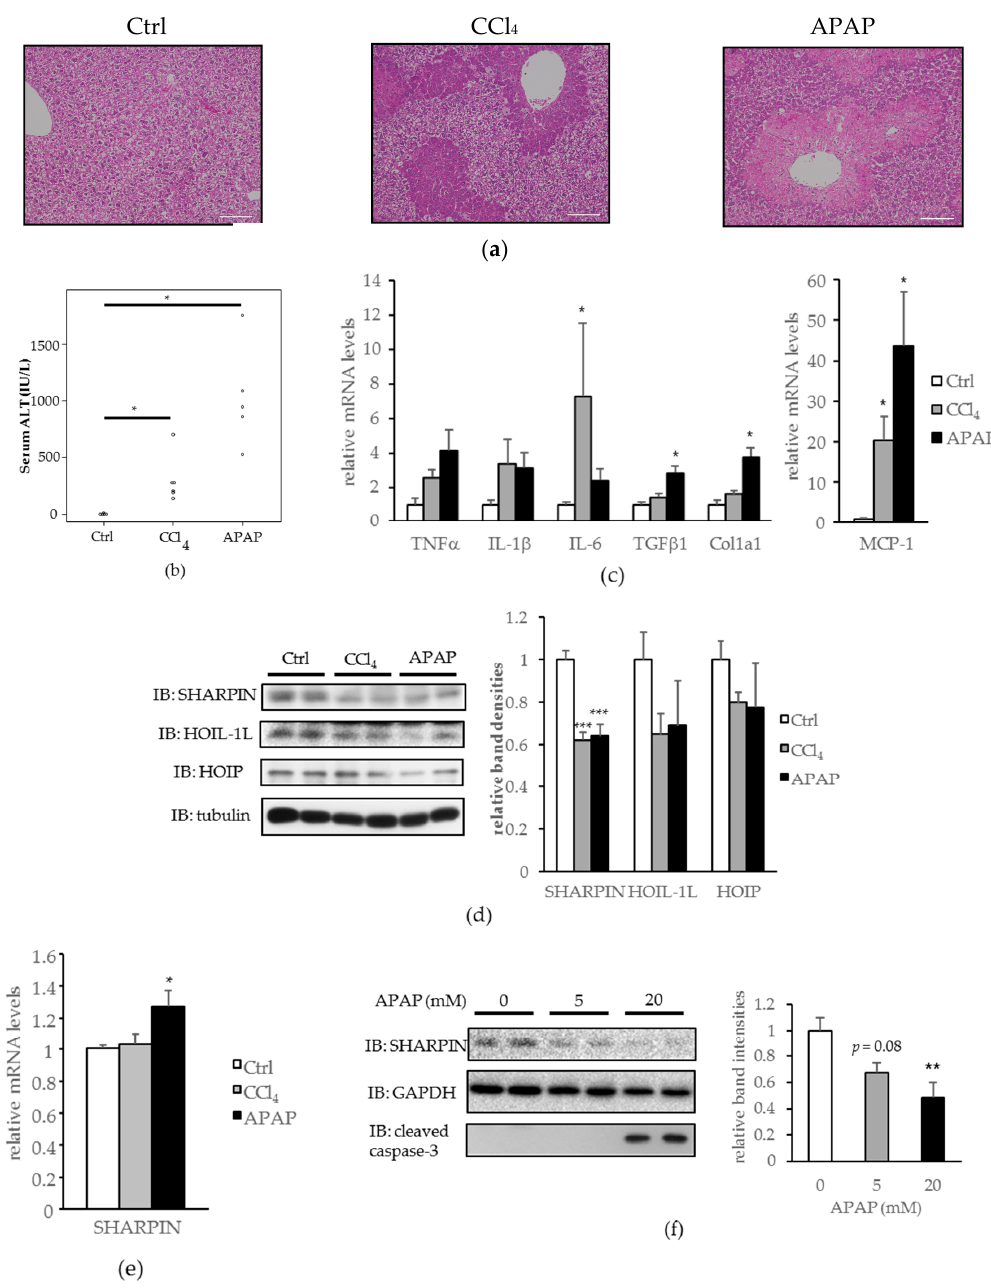
Figure 1. Downregulation of hepatic SHARPIN (SHANK-associated RH domain-interacting protein) by carbon tetrachloride (CCl 4 ) and acetaminophen (APAP) induced acute liver injury in mice, as well as in Hepa1-6 cells treated with APAP. ( a ) Mice were injected with CCl 4 (0.4 mL/kg) or APAP (300 mg/kg), and 24 h later their livers were removed and stained with hematoxylin and eosin (H-E). (Scale bar: 100 µm); ( b ) Serum alanine transaminase (ALT) level. ( n = 5–6); ( c ) mRNA levels of inflammatory and pro-fibrogenic cytokines in the liver. ( n = 5–6) (* p < 0.05); ( d ) Immunoblotting of each linear ubiquitin assembly complex (LUBAC) component in the liver. Relative band intensities after the adjustment for tubulin expression are shown as means + standard error (S.E.) ( n = 5–6) (* p < 0.05, *** p < 0.001); ( e ) mRNA levels of SHARPIN. ( n = 5–6) (* p < 0.05); ( f ) Immunoblotting of SHARPIN in Hepa1-6 cells after APAP stimulation for 24 h. Relative band intensities after the adjustment for glyceraldehyde-3-phosphate dehydrogenase (GAPDH) expression are shown as means + S.E. ( n = 4) (** p < 0.01)